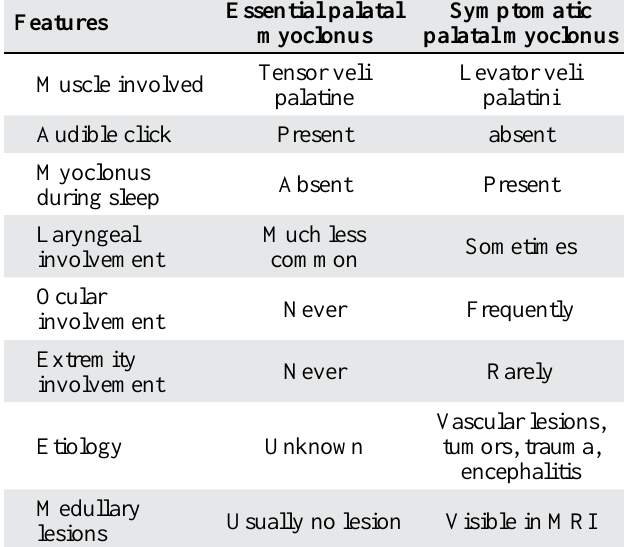
Table 1 : Salient features of two types of palatal myoclonus